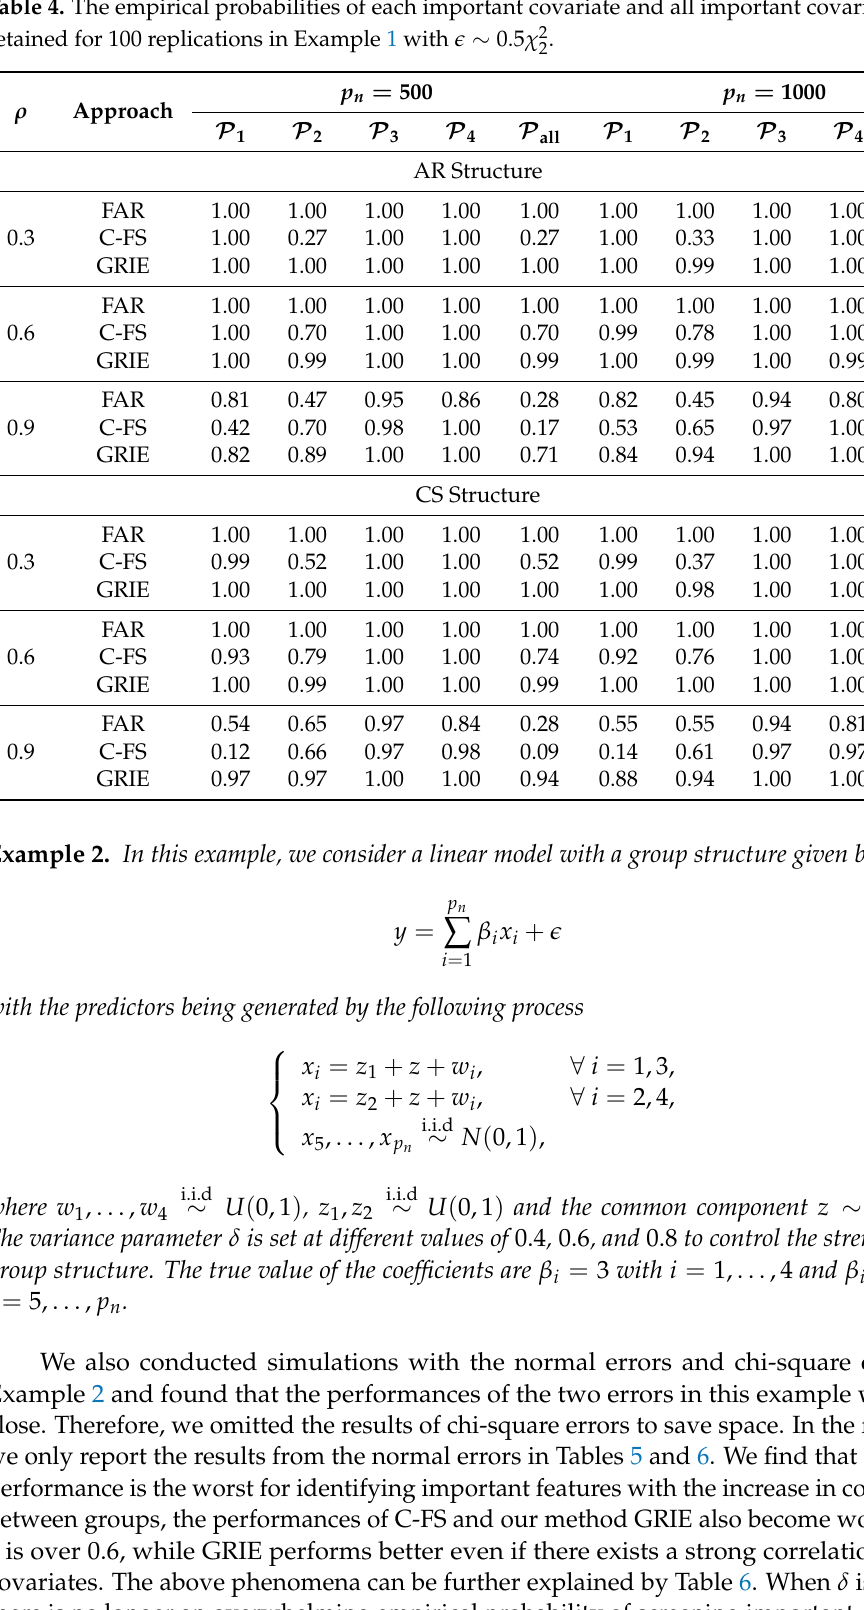
Table 4. The empirical probabilities of each important covariate and all important covariates being retained for 100 replications in Example 1 with (cid:101) ∼ 0.5 χ 2